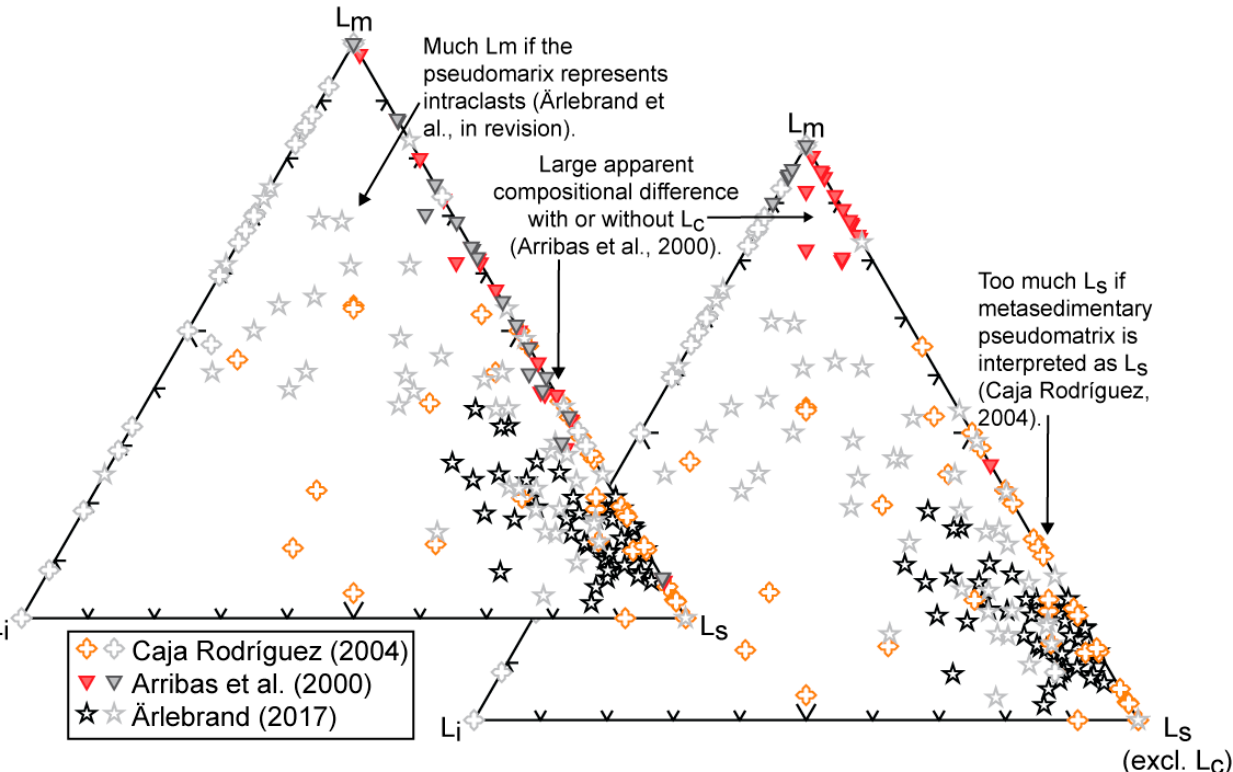
Figure 6. Effect of different interpretations of clay-mineral-rich clasts and pseudomatrix. The coloured symbols represent a composition where all clasts that have been interpreted as pelite clasts and pseudomatrix are assumed to be true pelite clasts. The grey symbols are compositions without pelite clasts, assuming that they represent intrabasinal clay clasts. Crystals of quartz, feldspar, and mica that were counted separately with the Gazzi–Dickinson method in Arribas et al. [47] were assigned to L m as specified in the original publication. Caja Rodríguez [45] applied the Indiana point-counting method, and Ärlebrand [40] used the Gazzi–Dickinson method with a 20 µm grain-matrix limit without specifying the rock-fragment types that single sand-sized crystals were part of. Cherty grains (microcrystalline quartz) are not included in the diagrams as they potentially may be either of sedimentary or volcanic origin. The diagrams are based on total average amounts of 91, 37, and 34 grains per sample for Arribas et al. [47], Caja Rodríguez [45], and Ärlebrand [40], respectively. L: lithic fragments; L c : carbonate L; L i : igneous L (both plutonic and volcanic grains); L m : metamorphic L; L s : sedimentary